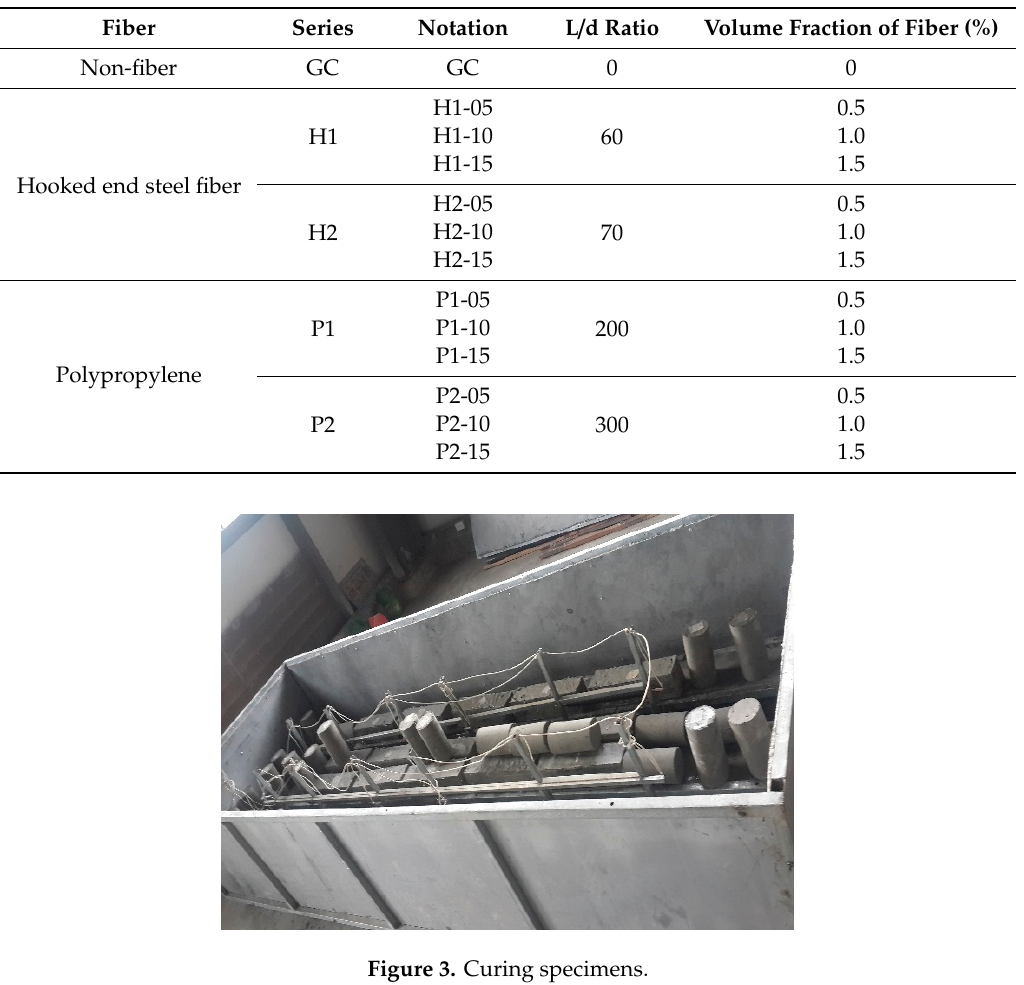
Table 4. Notation of series specimens.